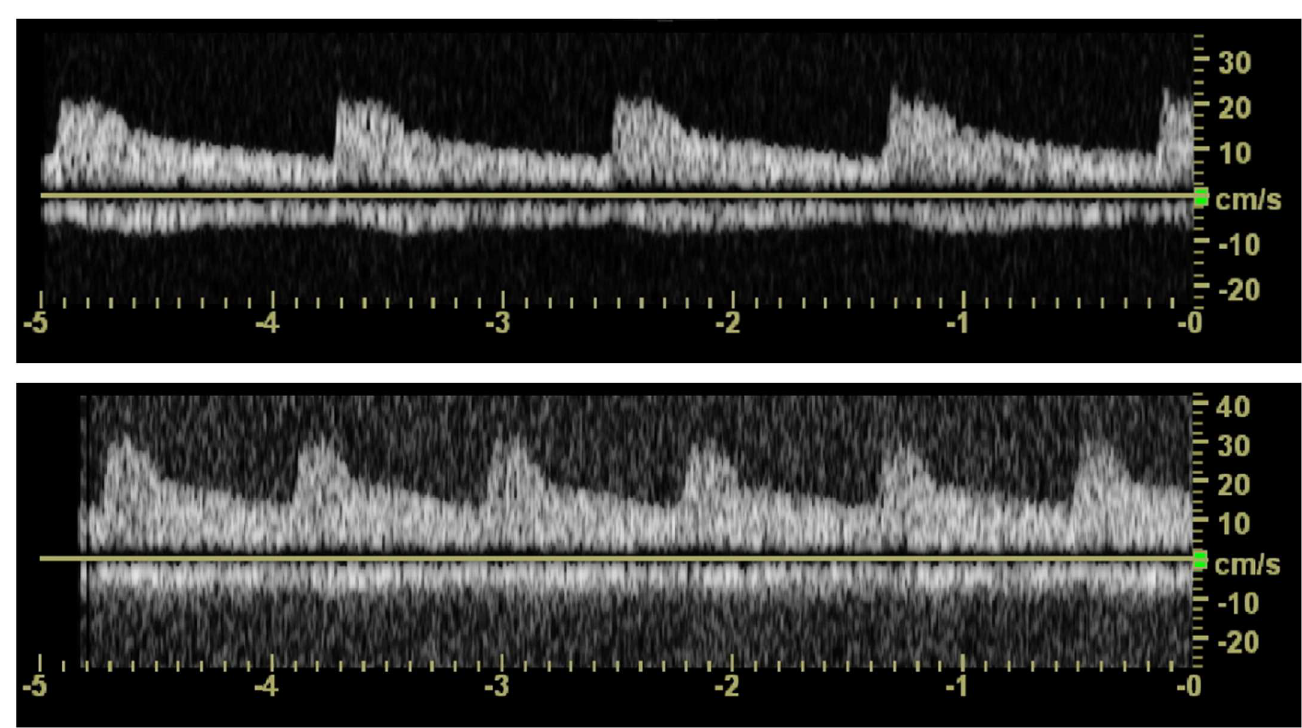
Fig 1. Full frame of uniform waves for 5 seconds. The Numbers of waves are different by the heart rates of participants (A, 48 beats per minute; B, 72 beats per